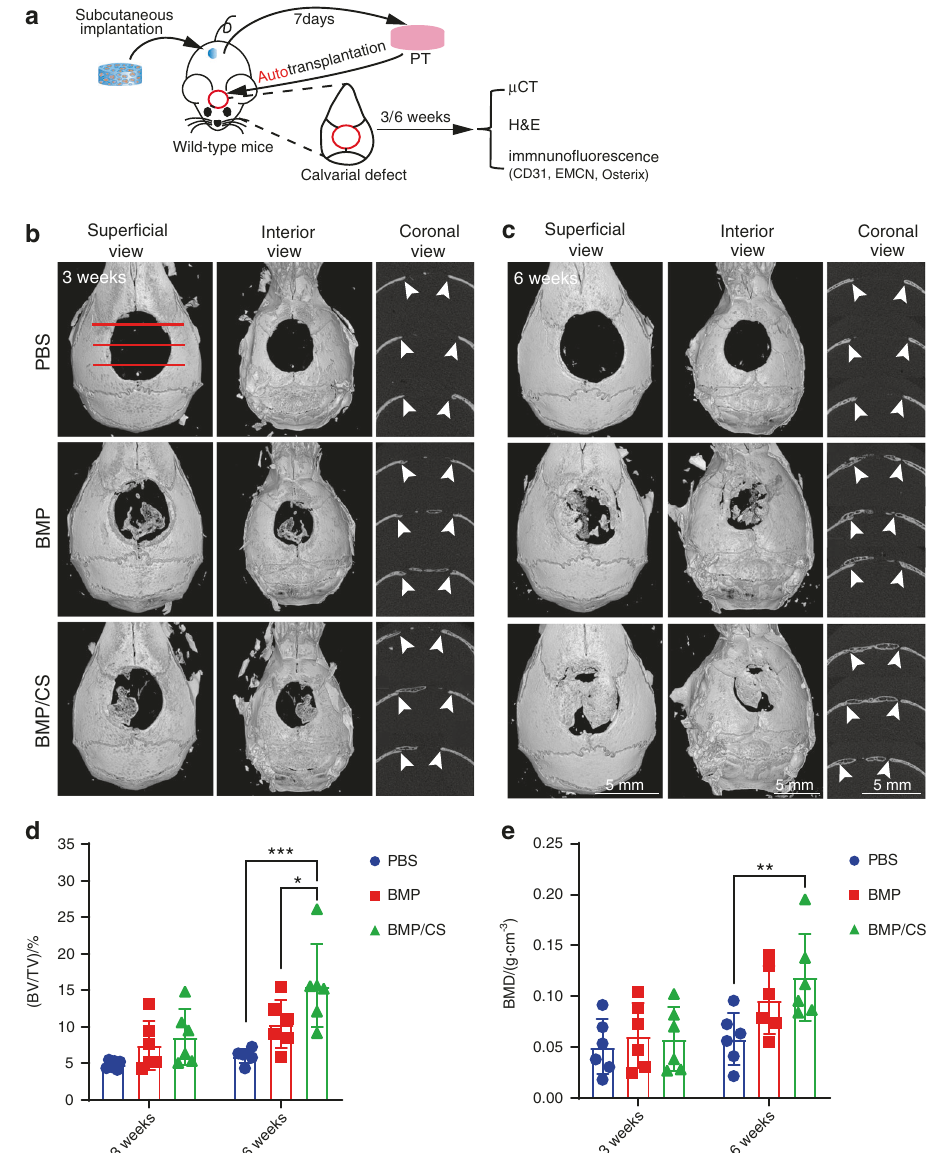
Fig. 5 PTs accelerate calvarial reconstruction via autologous transplantation. a Scheme of autologous transplantation. PTs from the PBS, BMP, or BMP/CS groups were explanted and transplanted into the same mice with 5 mm diameter calvarial defects ( n = 6). b , c Super fi cial, interior and coronal views of the cranium at weeks 3 ( b ) and 6 ( c ) after surgery. Images were taken at timed intervals for animals transplanted with PBS-, BMP-, or BMP/CS-induced autologous PTs. The white arrowhead indicates the integration site. Scale bar, 5 mm. d , e Quantitative analysis of bone volume fraction (BV/TV, d ) and bone mineral density (BMD, e ). Data were from individual animals and are shown as the mean ± SD.; * P < 0.05, ** P < 0.01, two-way ANOVA followed by Bonferroni ’ s post hoc